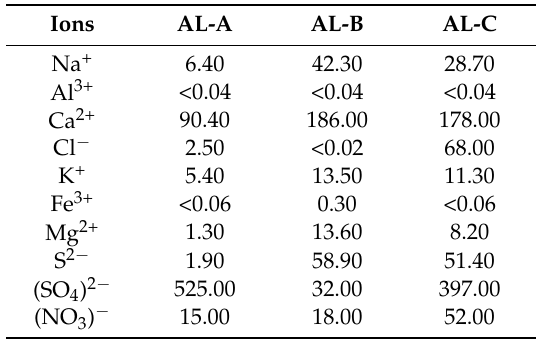
Table 7. Chemical analysis (mg·L − 1 ) of the washing waters.